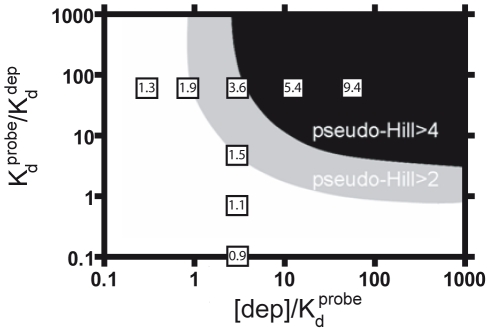
Simulation of the sequestration mechanism.A simulation of equations 1 and 2 illustrates the range of [dep]/Kdprobe and Kdprobe/Kddep over which pseudo-Hill coefficients above 2 (gray area) and above 4 (dark area) are obtained. Shown in boxes are some of the experimental pseudo-Hill coefficients we have observed (the horizontal and vertical lines of data were taken from figures 2 and 3 respectively).